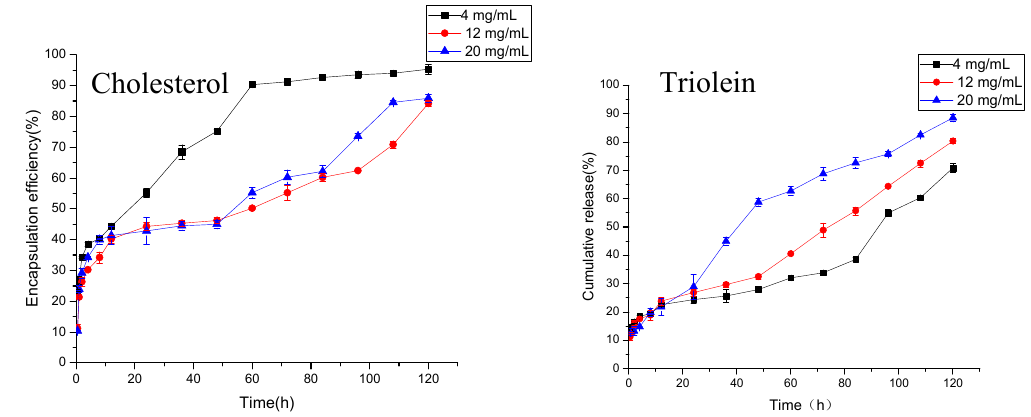
Figure 5. Cumulative release of AP-MVLs with di ff erent usages of cholesterol and